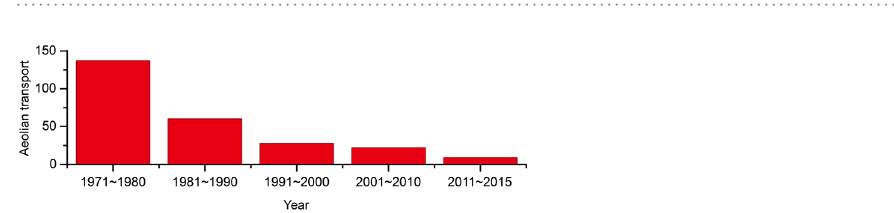
, where SD and Mean Mean